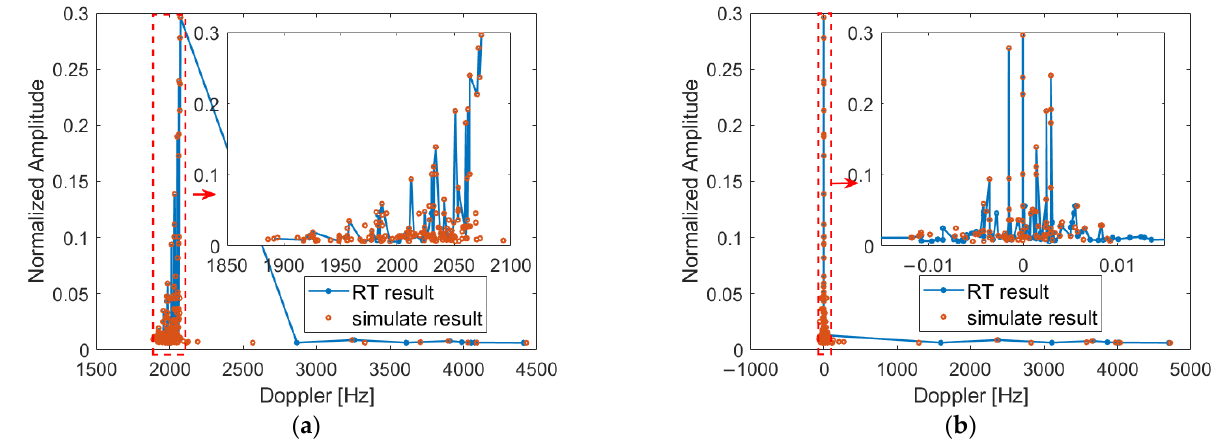
Figure 9. Doppler spread simulation results of T2T communication: ( a ) v t =160 km/h, v r =80 km/h, ( b ) v t =160 km/h, v r =160 km/h.